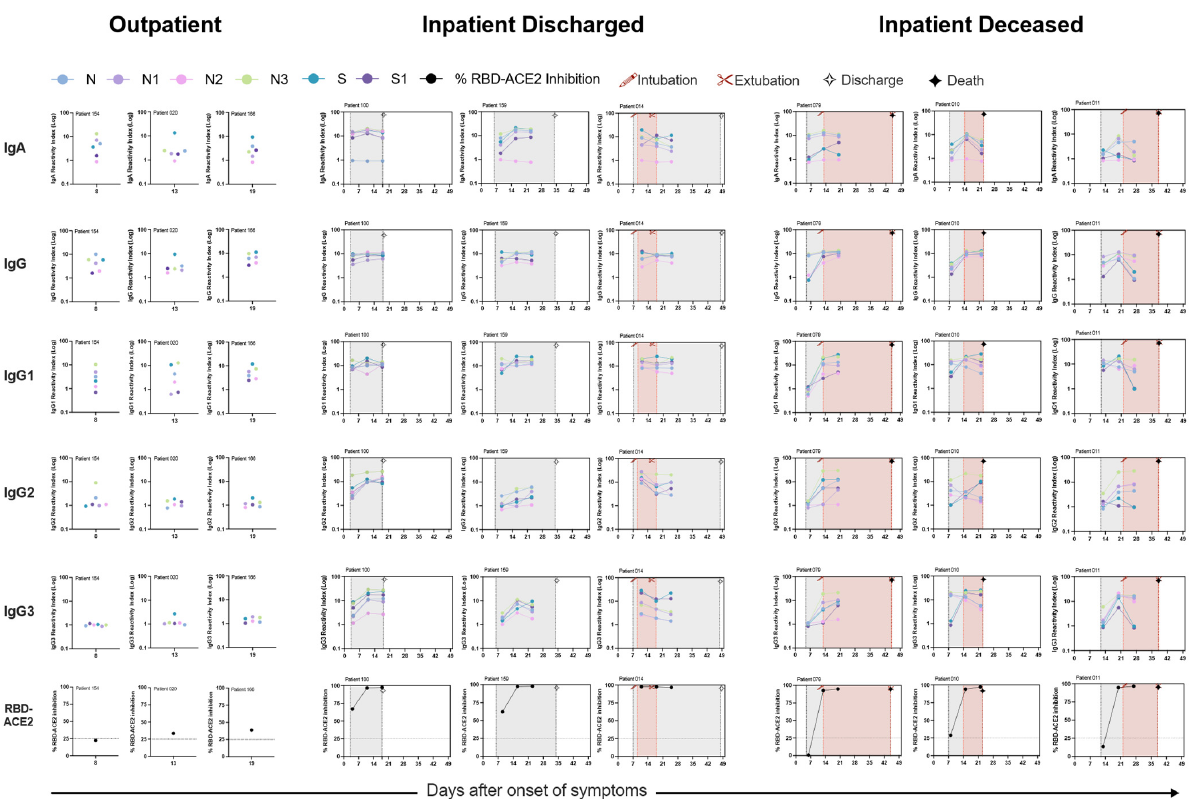
Figure 2. Representative COVID-19 patients and their humoral response: 100 ng of purified SARS-CoV-2 protein and 1:100 patient serum dilution was used in an indirect ELISA to estimate serum IgA, total IgG, IgG-subclass response and RBD-ACE inhibitory antibodies. Each column represents one patient, and each row represents specific response to one antibody isotype or RBD-ACE2 inhibitory antibodies. Each graph has reactivity index for SARS-CoV-2 full-length or truncated antigens tested. Outpatient samples were collected only at recruitment, whereas inpatients were followed longitudinally after hospitalization. Vertical dotted blank and red lines indicate hospitalized and intubation period, respectively (samples n = 3).